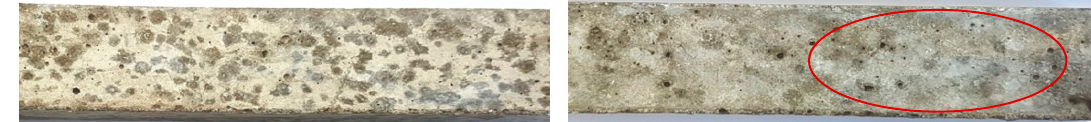
Figure 2. Expansion of mortars with reactive opal aggregate. 177